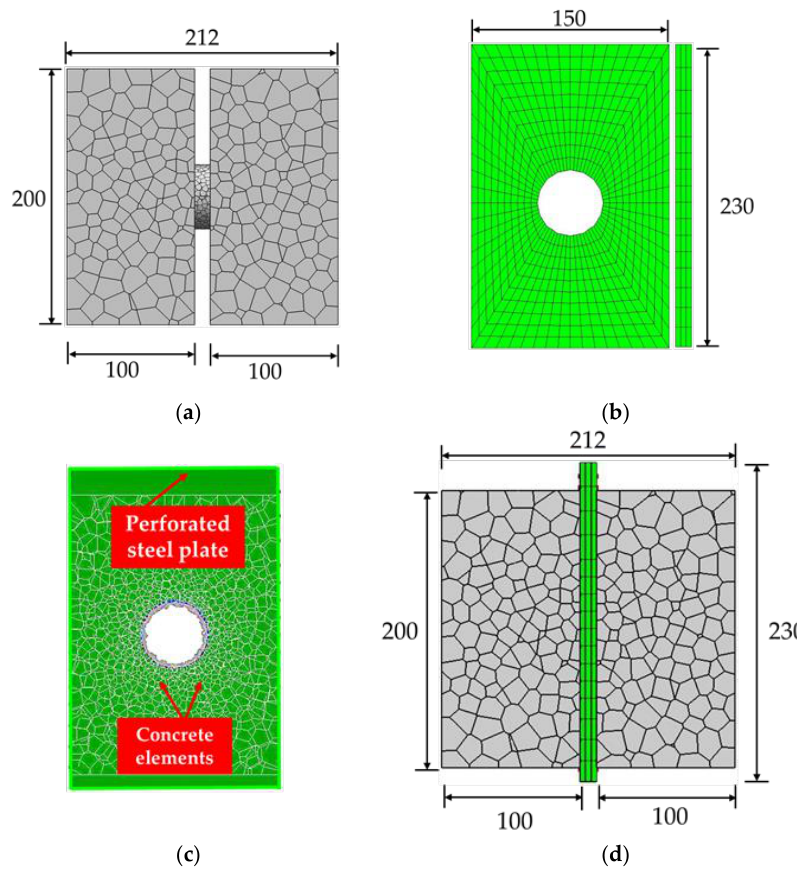
Figure 7. The analytical model of the test specimen (unit: mm): ( a ) Modeling of the concrete dowel and the side blocks; ( b ) Modeling of the perforated steel plate; ( c ) Representation of concrete and steel elements on the concrete–steel interface; ( d ) Analytical model of the PBL shear connector.